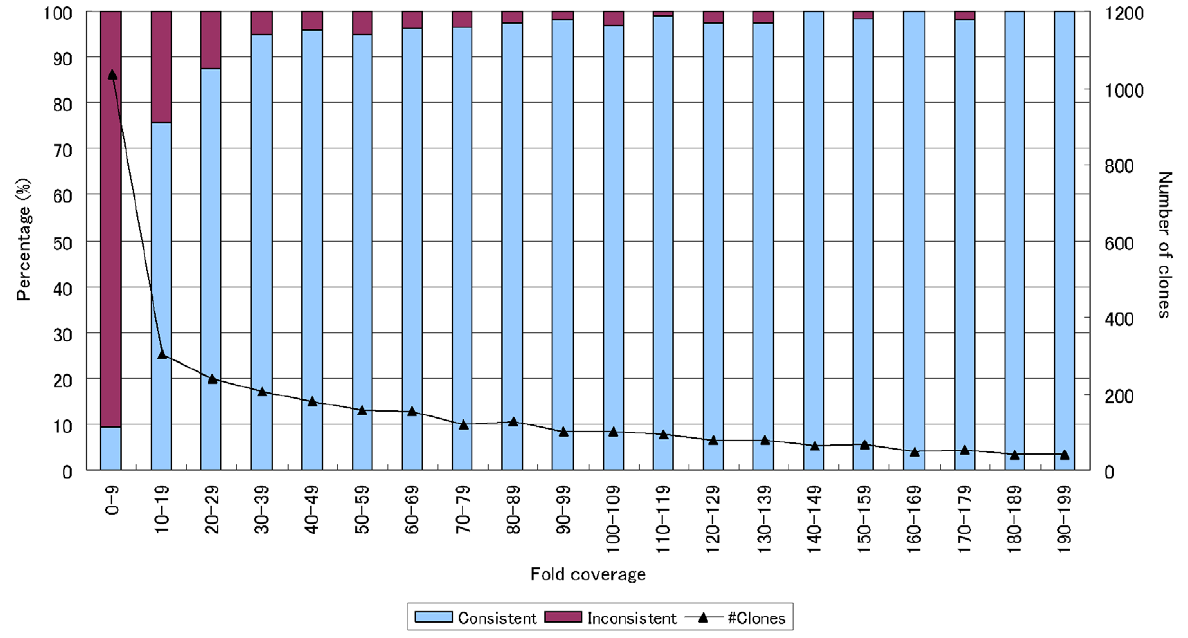
Figure 5. Relationship between the sequence coverage for each clone and the reconstruction accuracy in terms of CDS structure consistency. Clones in the simulated datasets were binned according to their per-clone sequence coverage. The bins were of every 10-fold. Note that every full-length cDNA clone was counted 10 times as it appeared with 10 different sequence coverage. We calculated the percentage of clones (left Y-axis) classified as consistent (or inconsistent) in terms of CDS structure for each bin. The number of clones in each bin is also shown (right Y- axis). Per-clone sequence coverage of 30-fold was sufficient to produce a CDS-consistent assembly in 95% of the cases, showing that uniform coverage distribution is highly desirable to achieve better efficiency.